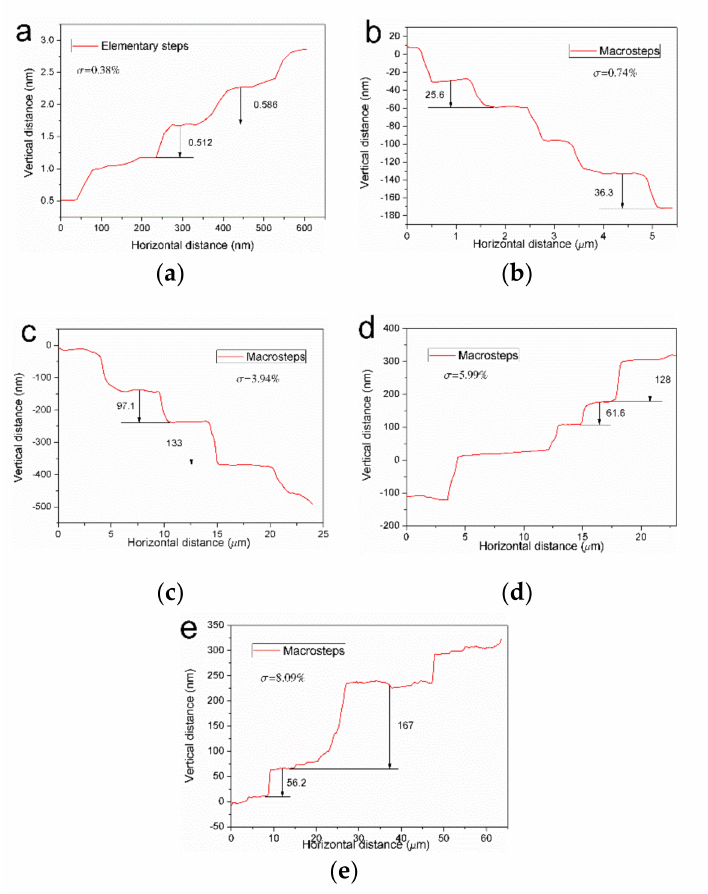
Figure 2. Steps profile images measured by AFM under di ff erent supersaturation: ( a ) σ = 0.38%; ( b ) σ = 0.74%; ( c ) σ = 3.94%; ( d ), σ = 5.99%; ( e ), σ =